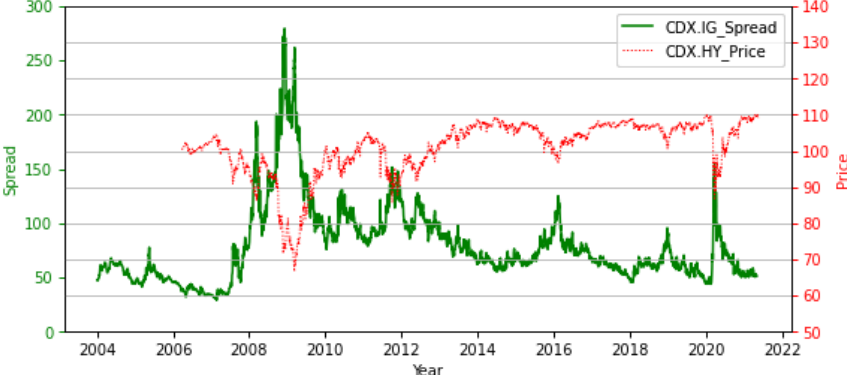
Figure 4. Time series of GDP (see right y-axis) and DRs (see left y-axis) for ratings A and Baa ( left panel ) and for ratings Ba and B ( right panel ).